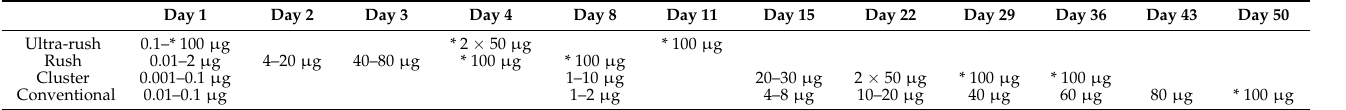
Table 1. Scheme of subcutaneous Hymenoptera venom administration according to different protocols